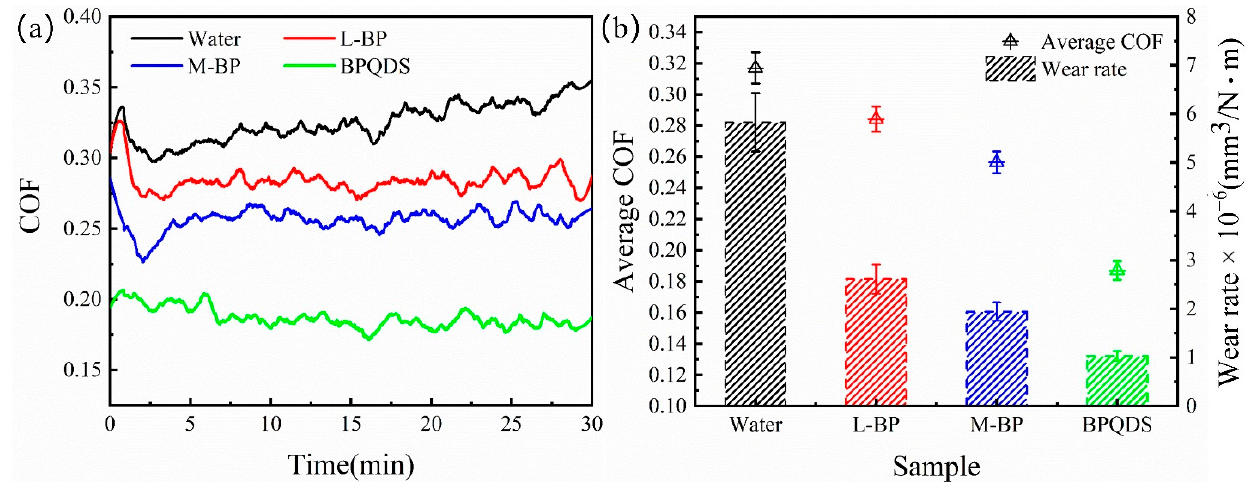
Figure 5. ( a ) COF versus sliding time. ( b ) Average COF and wear rate for the ultrapure water and different-sized BP-NS lubricants (0.075 wt.%, 10 N).